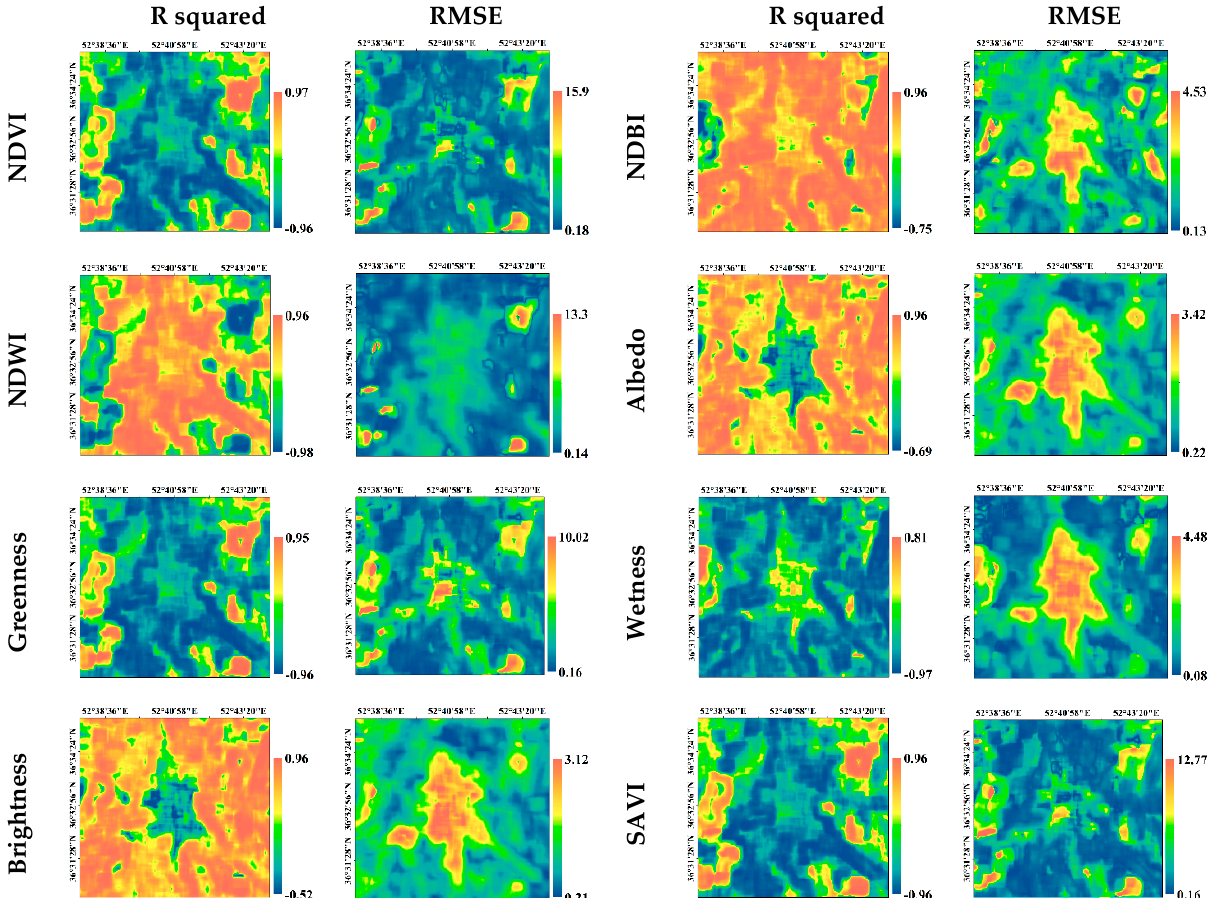
Figure 10. Correlation coefficient and RMSE between the observed and modeled values of LST variations at the pixel scale based on each surface biophysical parameter variations.